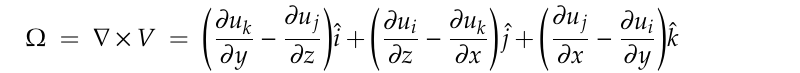
Figure 8. Vorticity magnitude distributions with respect to corrugation profiles at x = 0.0156 m.